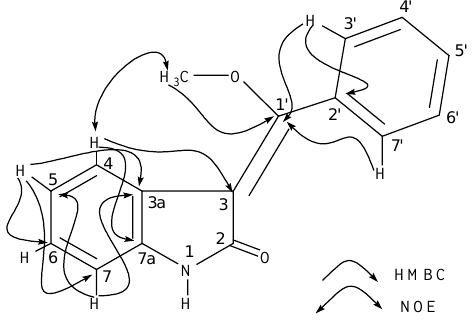
Figure 2. Important HMBC and NoE correlations of isatinone A ( 1